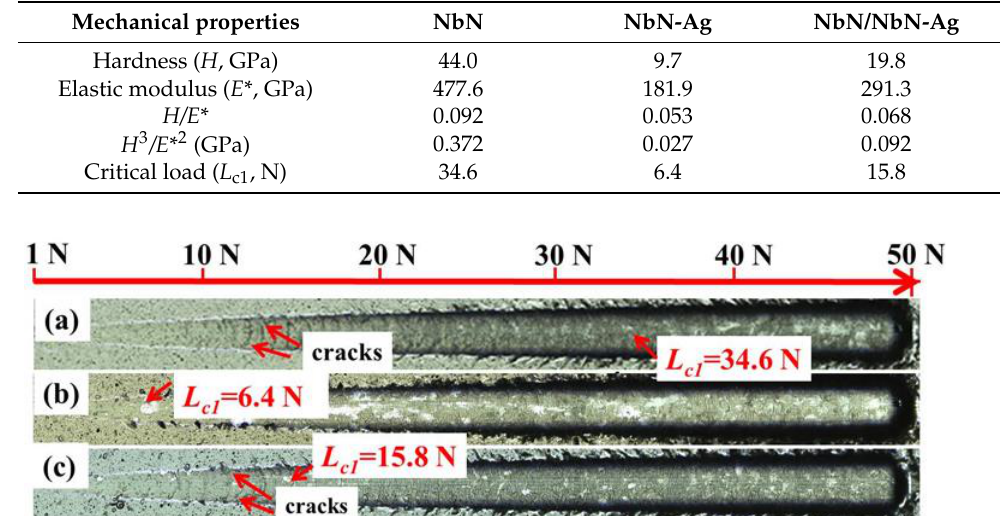
Table 2. The mechanical performances of the studied films.